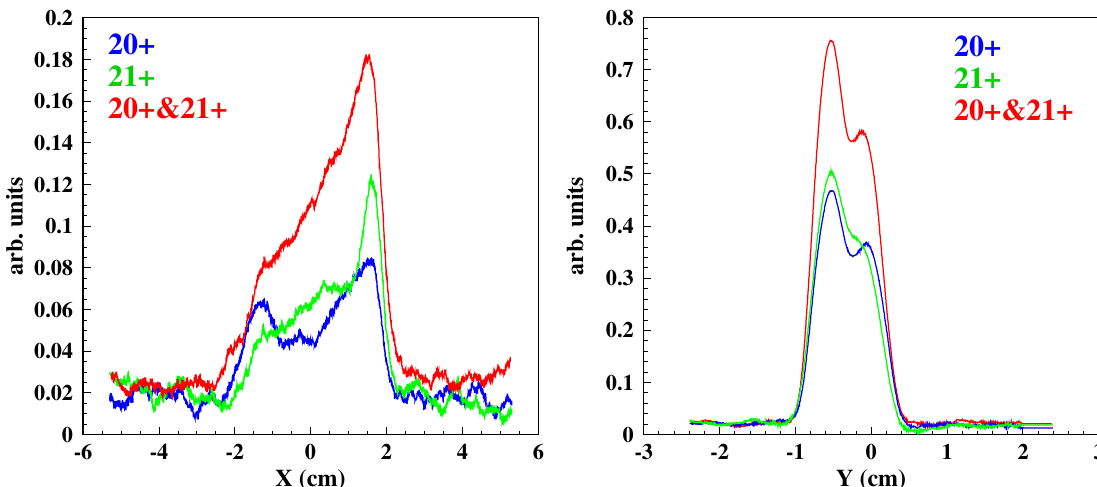
FIG. 6. (Color) Measured bismuth beam profiles on the wire scanner downstream of the second bending magnet.